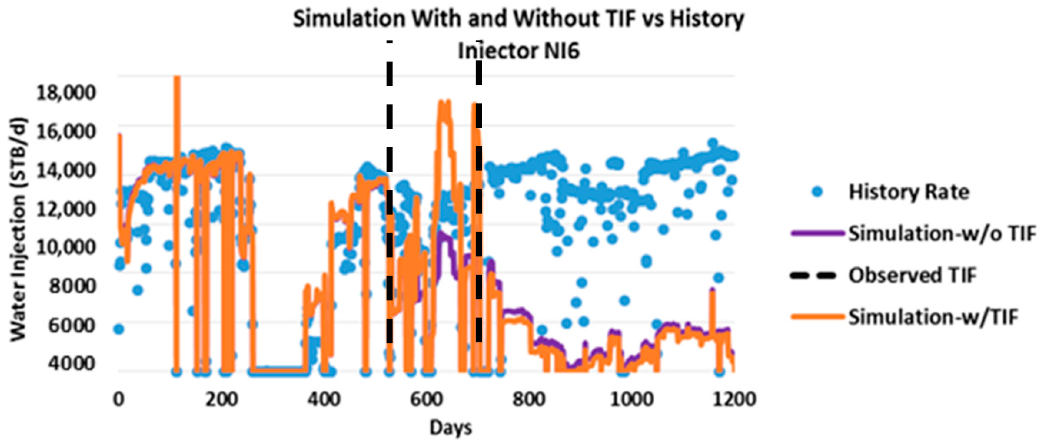
Figure 28. Simulation run with and without TIF models versus Injector CW6 historical data.